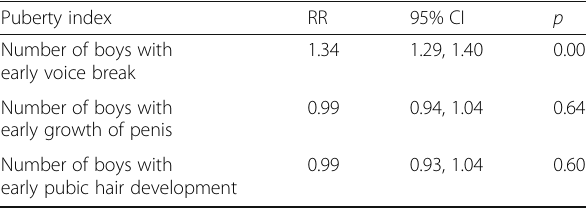
Table 4 Risk ratio (RR) and 95%CI of number of boys with early puberty index development with PTS exposure in Ravnborg